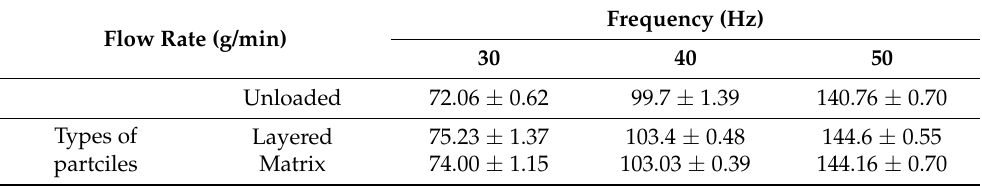
Table 4. The flow rate generated by the different frequencies for various samples (mean ± SD, n = 3).